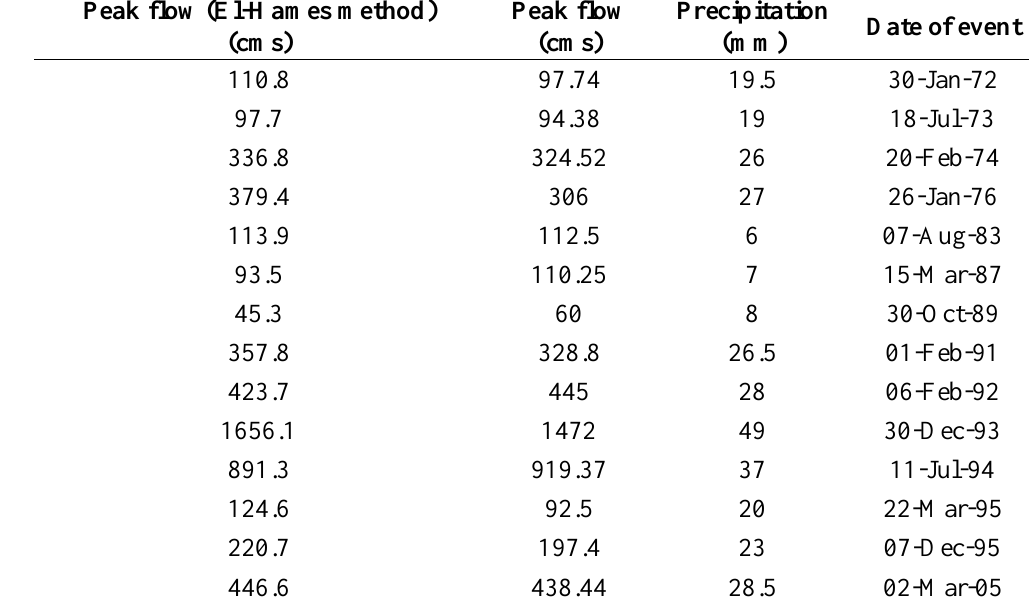
Table 4. Comparison between the peak flows measured by Bampour gauging stations and those calculated by El-Hames